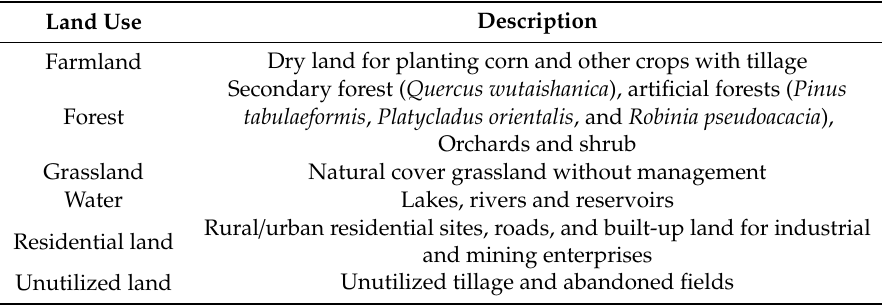
Table 3. Description of di ff erent land use